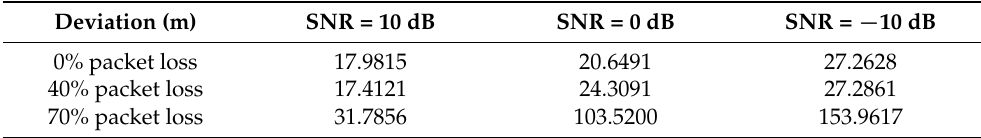
Figure 14. The comparison between the location result calculated by the GB-TRI method and the true location of the seismic source under different noise and packet loss conditions. Table 3. Deviation under different SNR and packet loss